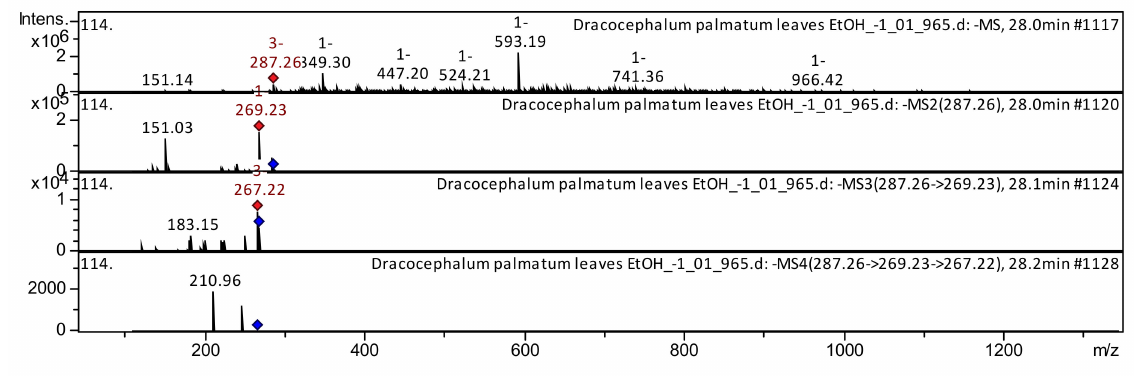
Figure 9. CID spectrum of dihydrokaempferol from extracts of D. palmatum , m / z 287.26.